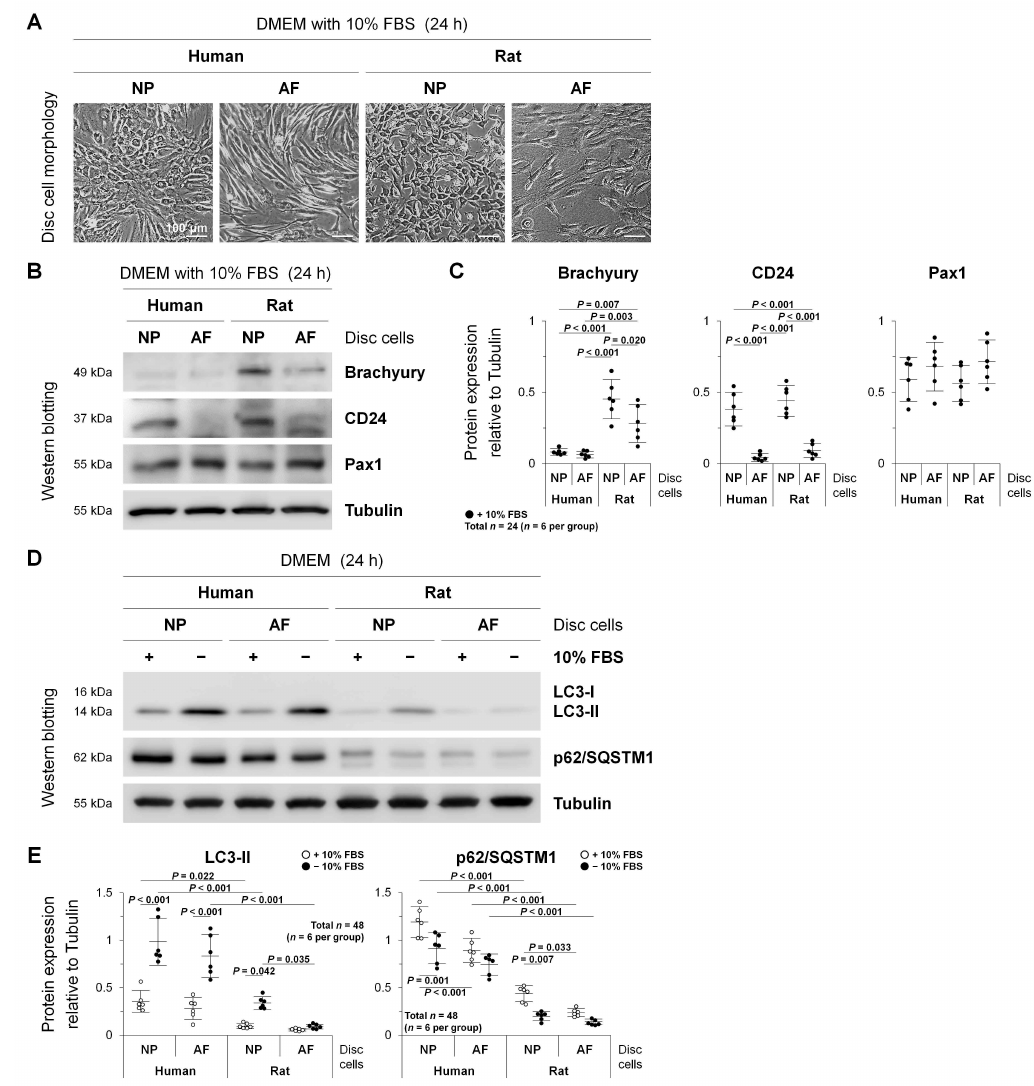
Figure 1. Autophagy in human degenerated and rat non-degenerated disc NP and AF cells. ( A ) Morphological appearance of human and rat lumbar disc NP and AF cells after 24 h culture in DMEM with 10% FBS. Cellular images (human NP and AF cells from the L4–L5 disc with the Pfirrmann grade 3 in a 64-year-old woman) are representative of experiments with similar results ( n = 6). ( B ) Western blotting for NP notochordal markers brachyury and CD24 and NP and AF marker Pax1 in total protein extracts from human and rat lumbar disc NP and AF cells after 24 h culture in DMEM with 10% FBS. Tubulin was used as a loading control. Immunoblots shown (human NP and AF cells from the L4–L5 disc with the Pfirrmann grade 3 in a 64-year-old woman) are representative of experiments with similar results ( n = 6). ( C ) Changes in protein expression of brachyury, CD24, and Pax1 relative to tubulin in human and rat lumbar disc NP and AF cell protein extracts. Data are the mean ± 95% CI. Two-way ANOVA with the Tukey–Kramer post-hoc test was used ( n = 6). ( D ) Western blotting for autophagy marker LC3, autophagy substrate p62/SQSTM1, and loading control tubulin in total protein extracts from human and rat lumbar disc NP and AF cells after 24 h culture in DMEM with and without 10% FBS for serum deprivation. Immunoblots shown (human NP and AF cells from the L4–L5 disc with the Pfirrmann grade 3 in a 64-year-old woman) are representative of experiments with similar results ( n = 6). ( E ) Changes in protein expression of LC3-II and p62/SQSTM1 relative to tubulin in human and rat lumbar disc NP and AF cell protein extracts. Data are the mean ± 95% CI. Two-way ANOVA with the Tukey–Kramer post-hoc test was used ( n =